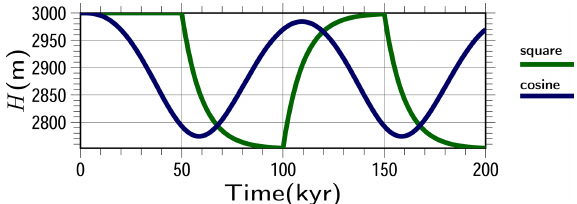
Figure 11. Prescribed time evolution patterns of ice thickness adopted in the non-steady thickness experiment. The thickness evo- lution is computed using an e -folding time of 10kyr against square- wave and cosine-wave formulation of the surface mass balance with a H ,a L = 3 and 1.5cmyr − 1 (Fig. 6) provided as an